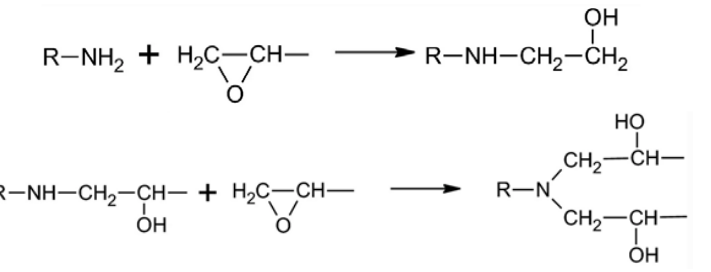
Figure 1. The polyaddition reaction of amines (the amine reacts with the epoxide oxygen and forms a hydroxyl group) [9] . The means of crosslinking fundamentally affects the properties of epoxy thermosets.